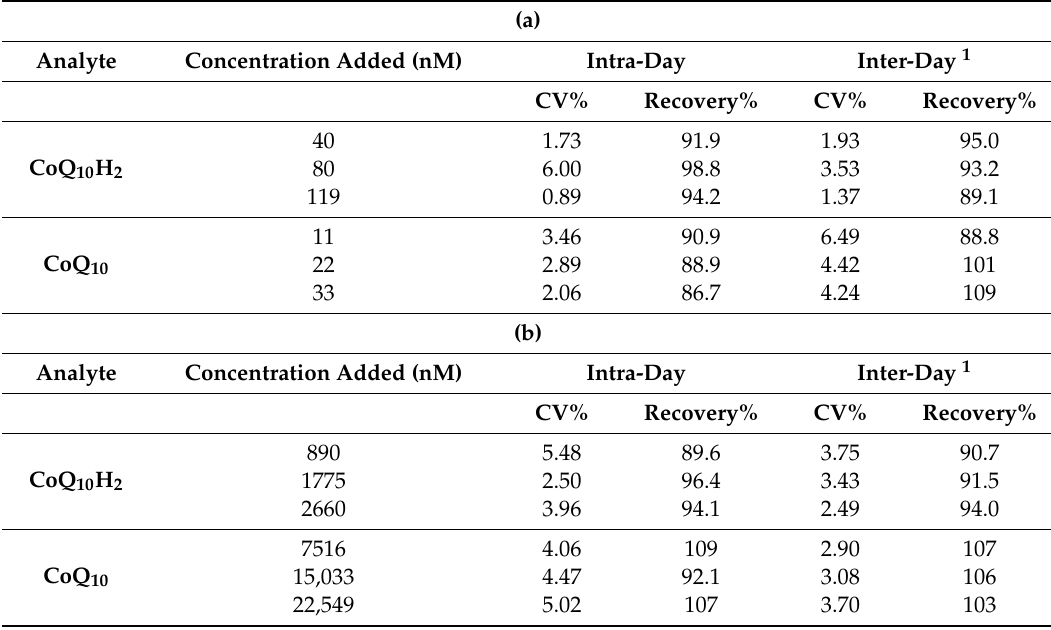
Table 1. (a) Precision (CV%) and accuracy (recovery%) for the quantification of CoQ 10 H 2 and CoQ 10 in canine plasma determined within one day ( n = 5) or in three di ff erent days ( n = 5). (b) Precision (CV%) and accuracy (recovery%) for the quantification of CoQ 10 H 2 and CoQ 10 in canine heart tissue determined within one day ( n = 5) or in three di ff erent days ( n = 5).